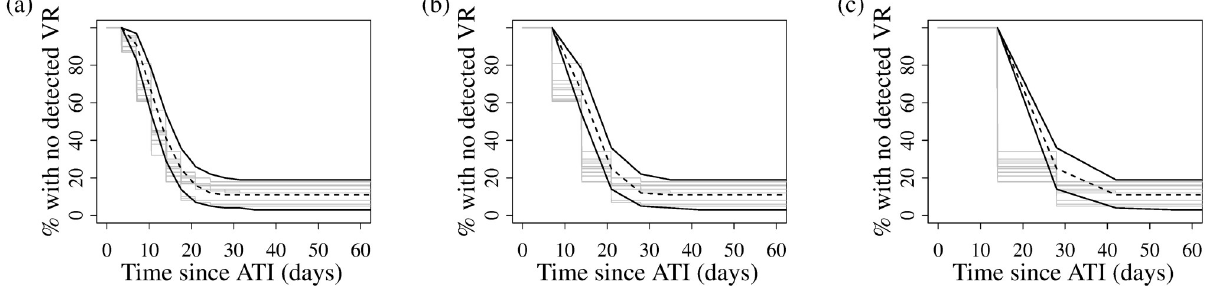
Fig 10. In silico ATI study survival curves. Ten sample survival curves for in silico studies with 100 study participants whose pre-ATI ART regimen included NNRTIs. Median (dashed line) and and 99% confidence interval (solid lines) computed from 10000 simulations. Survival curves describe model-predicted time to detectable viral rebound, given a post-ATI viral load testing schedule with (a) twice-weekly, (b) weekly, or (c) every two week testing.